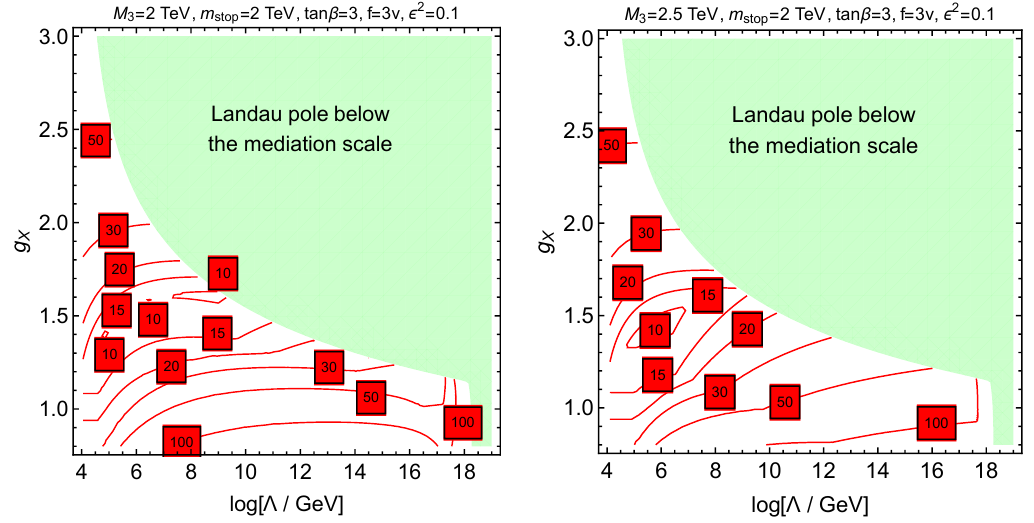
Figure 3 . The same as in (cid:12)gure 2 but in the plane (cid:3)- g X for m stop = 2 TeV, tan (cid:12) = 3 and M 3 = 2 TeV (left panel) or 2.5 TeV (right panel). For the chosen values of m stop and tan (cid:12) , the Higgs mass is in agreement with the measured value within theoretical uncertainties in the most of parameter space. For g X & 1 : 5 the Higgs mass is slightly too big which can be compensated by reducing tan (cid:12) by about 10 % which would have negligible impact on